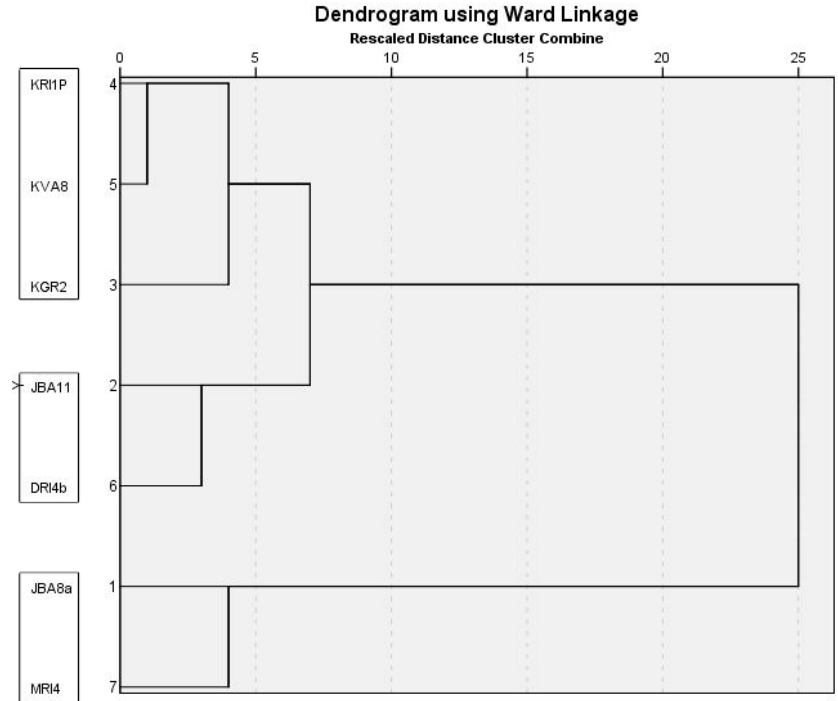
Figure 4. Dendogram showing the grouping of Penicillium expansum isolates based on colony di- ameter on different media (PDA, MEA, CYA, and YES), reverse on PDA and MEA (cream or yel- low), and CYA reverse characteristics, using Ward’s model with Euclidian Distance interval. P. expansum isolates within a clade are indicated in black boxes.